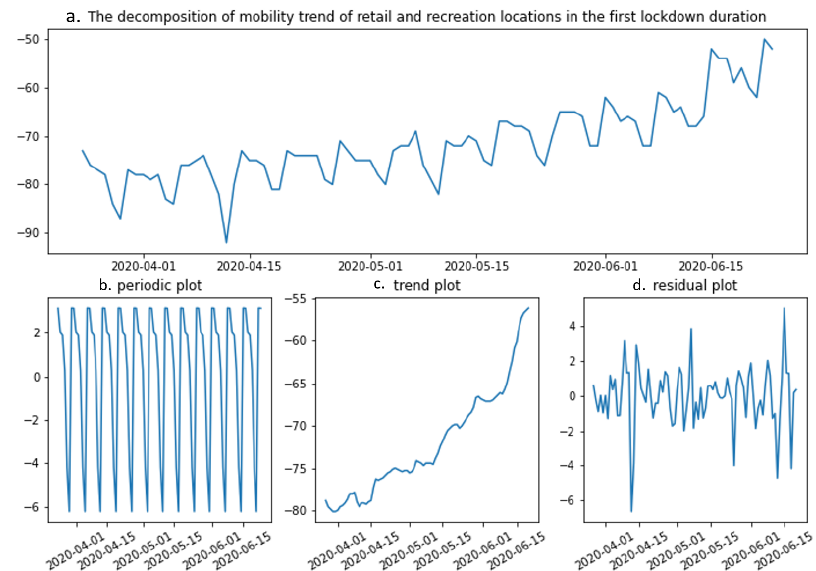
Figure 4. The decomposition of retail and recreation mobility during the first lockdown period in Leeds. According to the additive model in time series, the original mobility curve ( a ) is the sum of three components: seasonal component ( b ), trend component ( b , c ), and random ( d ) curves.